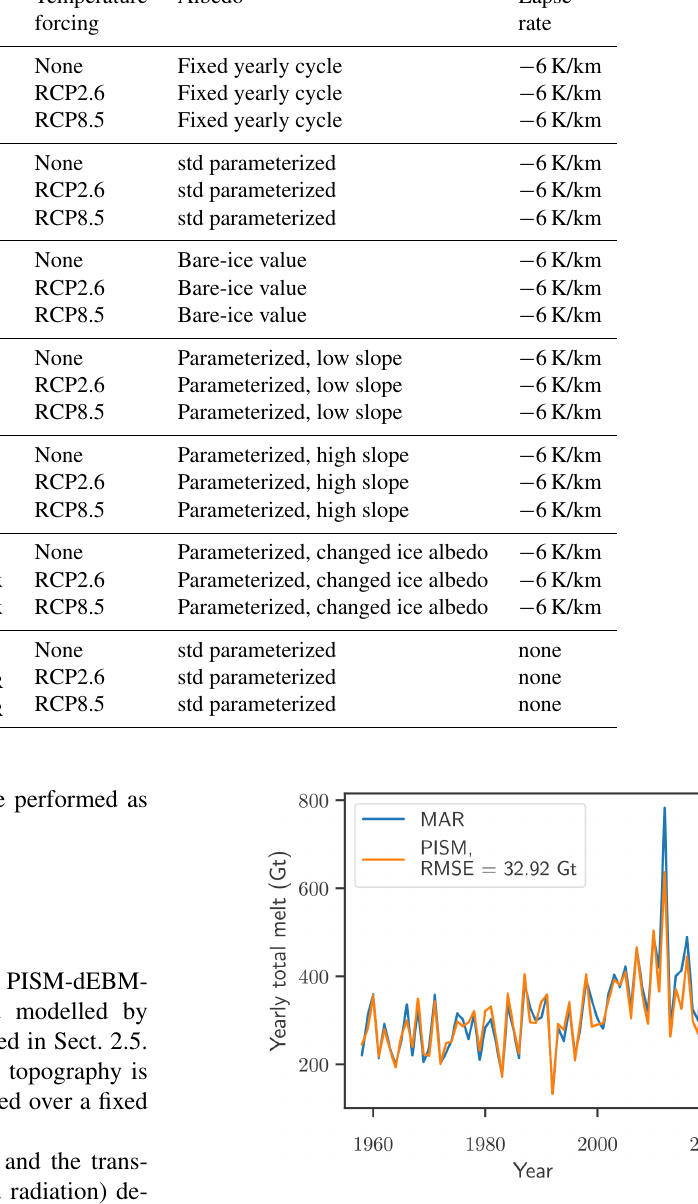
Table 1. Overview of the experiments performed in this study. Experiment